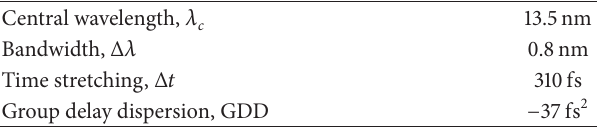
Table 1: Requirements for the FEL